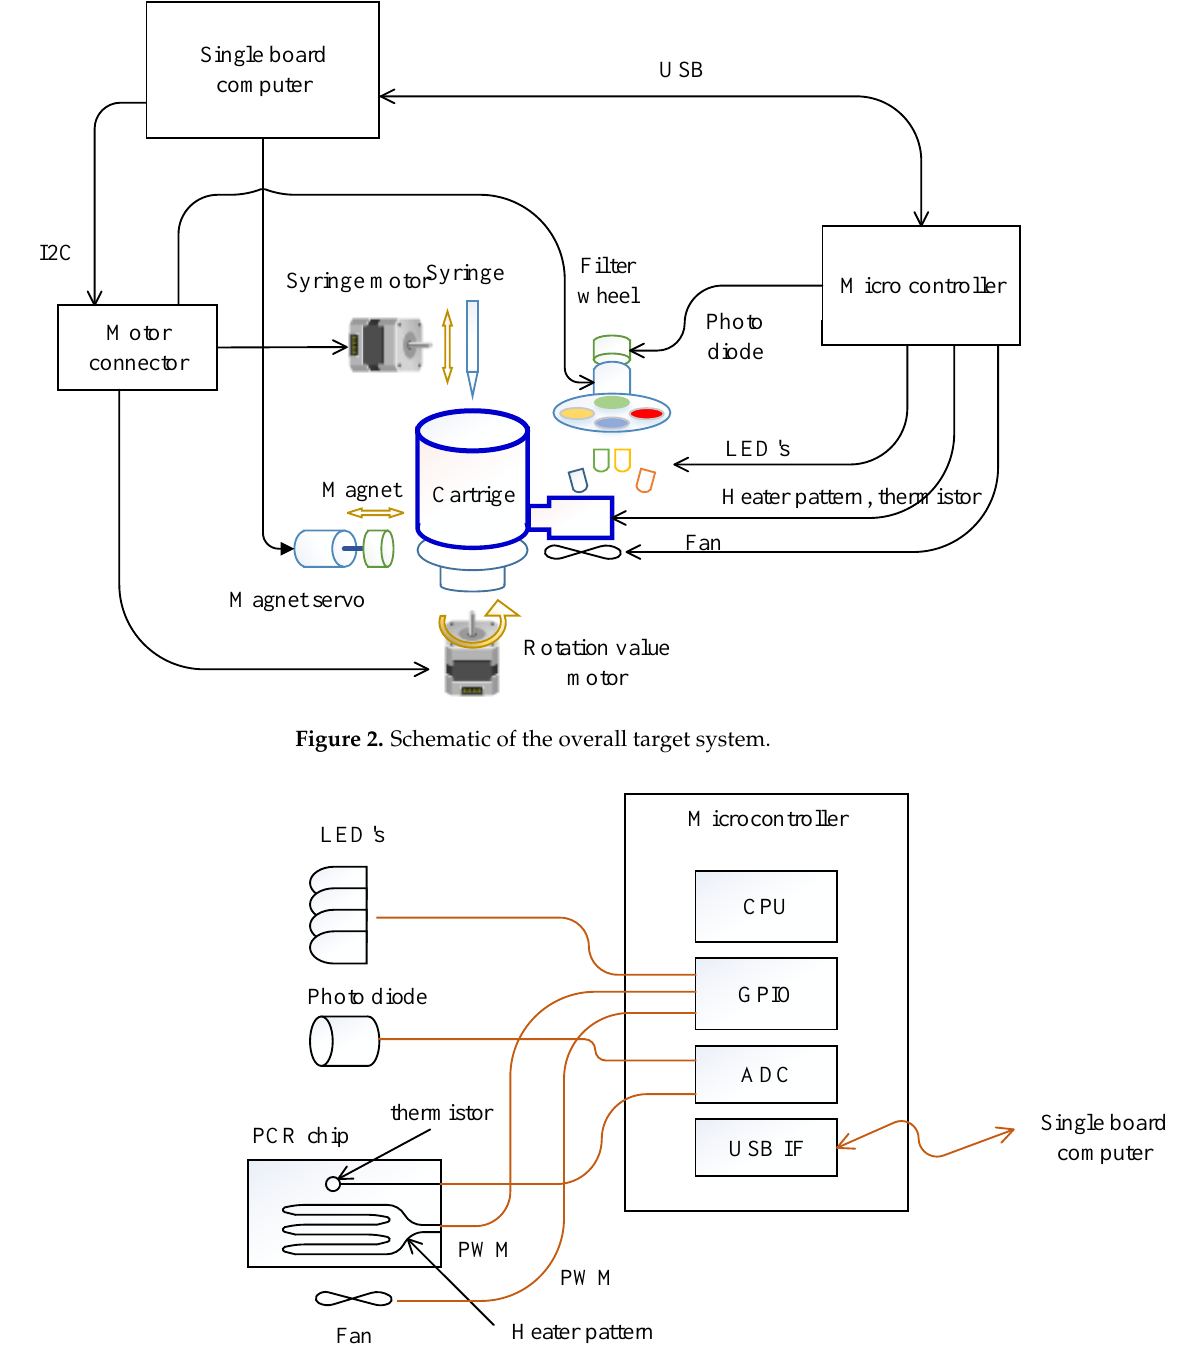
I2C Figure 4. Software architecture block diagram.